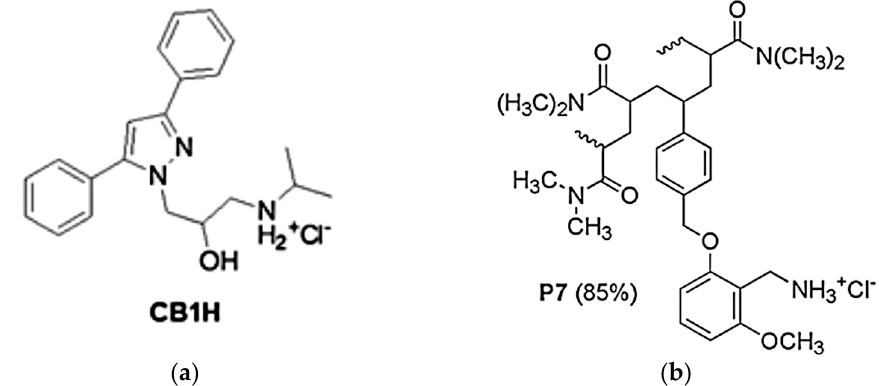
Figure 2. Structure of CB1H ( a ) and of copolymer P7 ( b ).